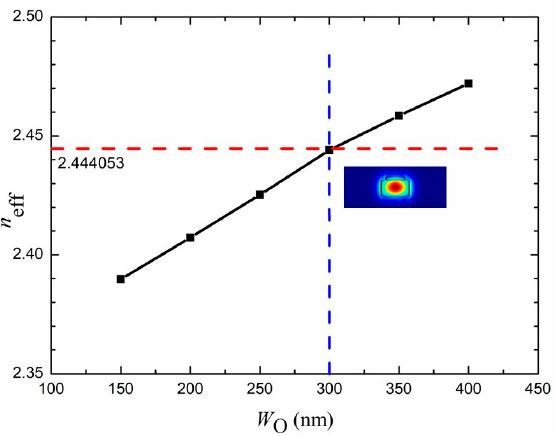
Figure 3. The relation of effective refractive index and the width of GSST W O .